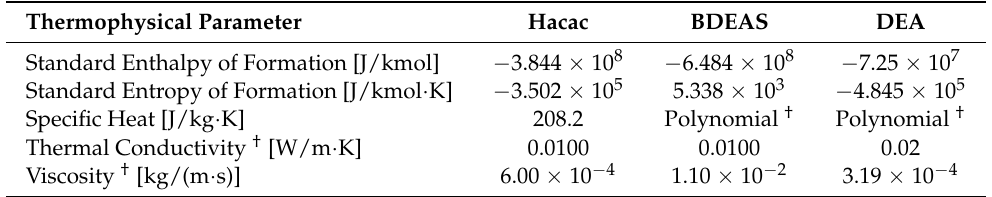
Table 2. Thermophysical material properties of species specified in the gas phase in Ansys Fluent. Thermophysical